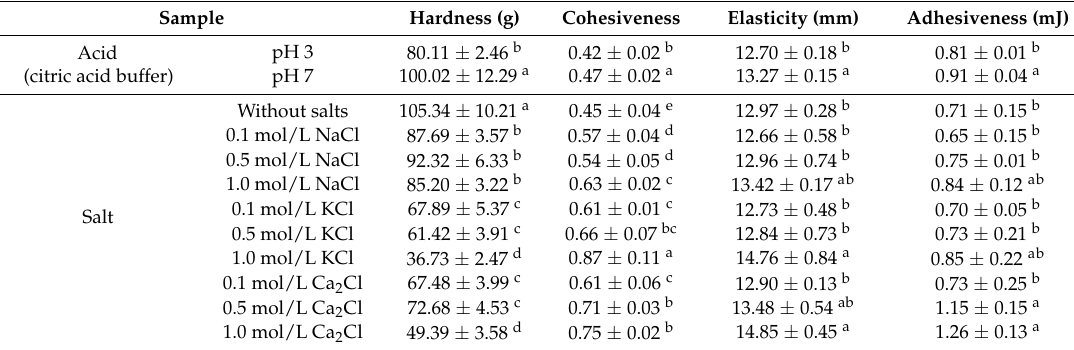
Table 3. Texture Parameters of the LRS/KGM mixed system in acid or salt